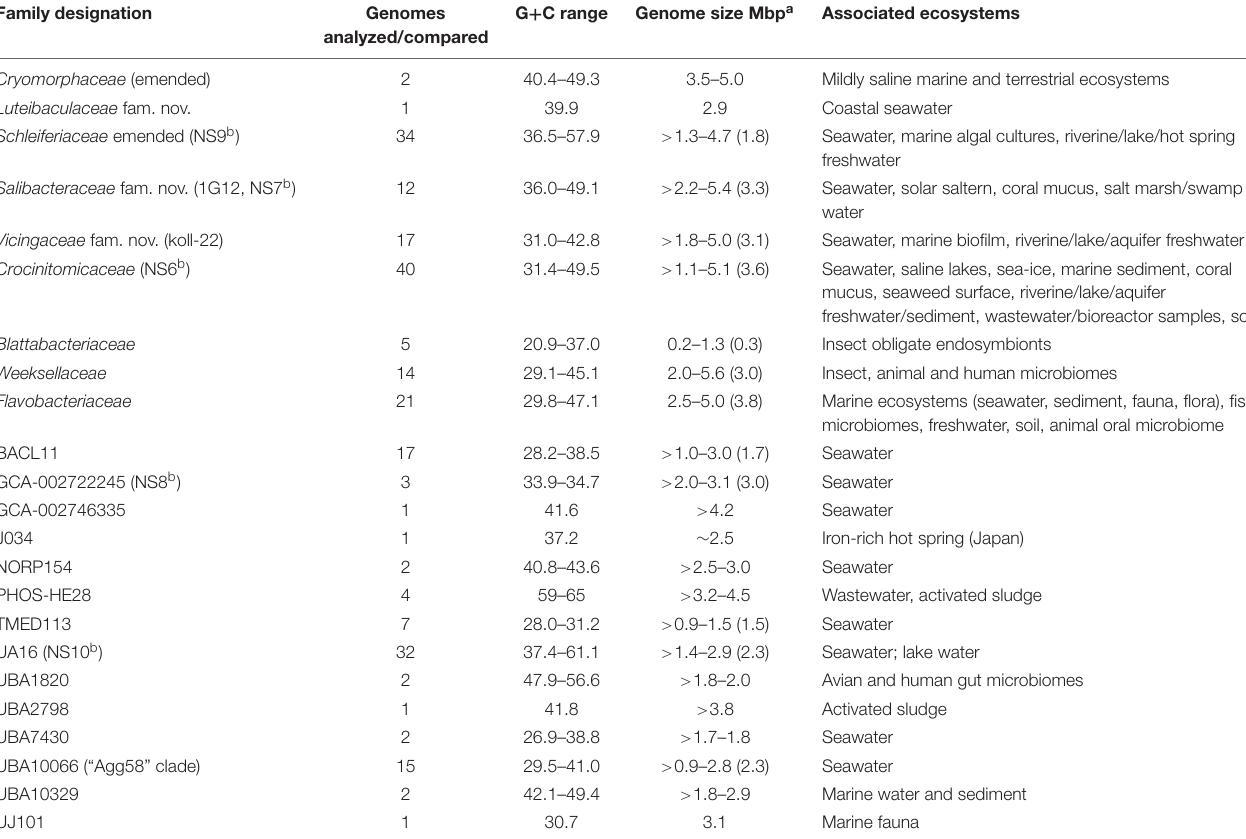
TABLE 2 | Genomic-level and habitat characteristics of family level lineages of order Flavobacteriales (based on data investigated in this